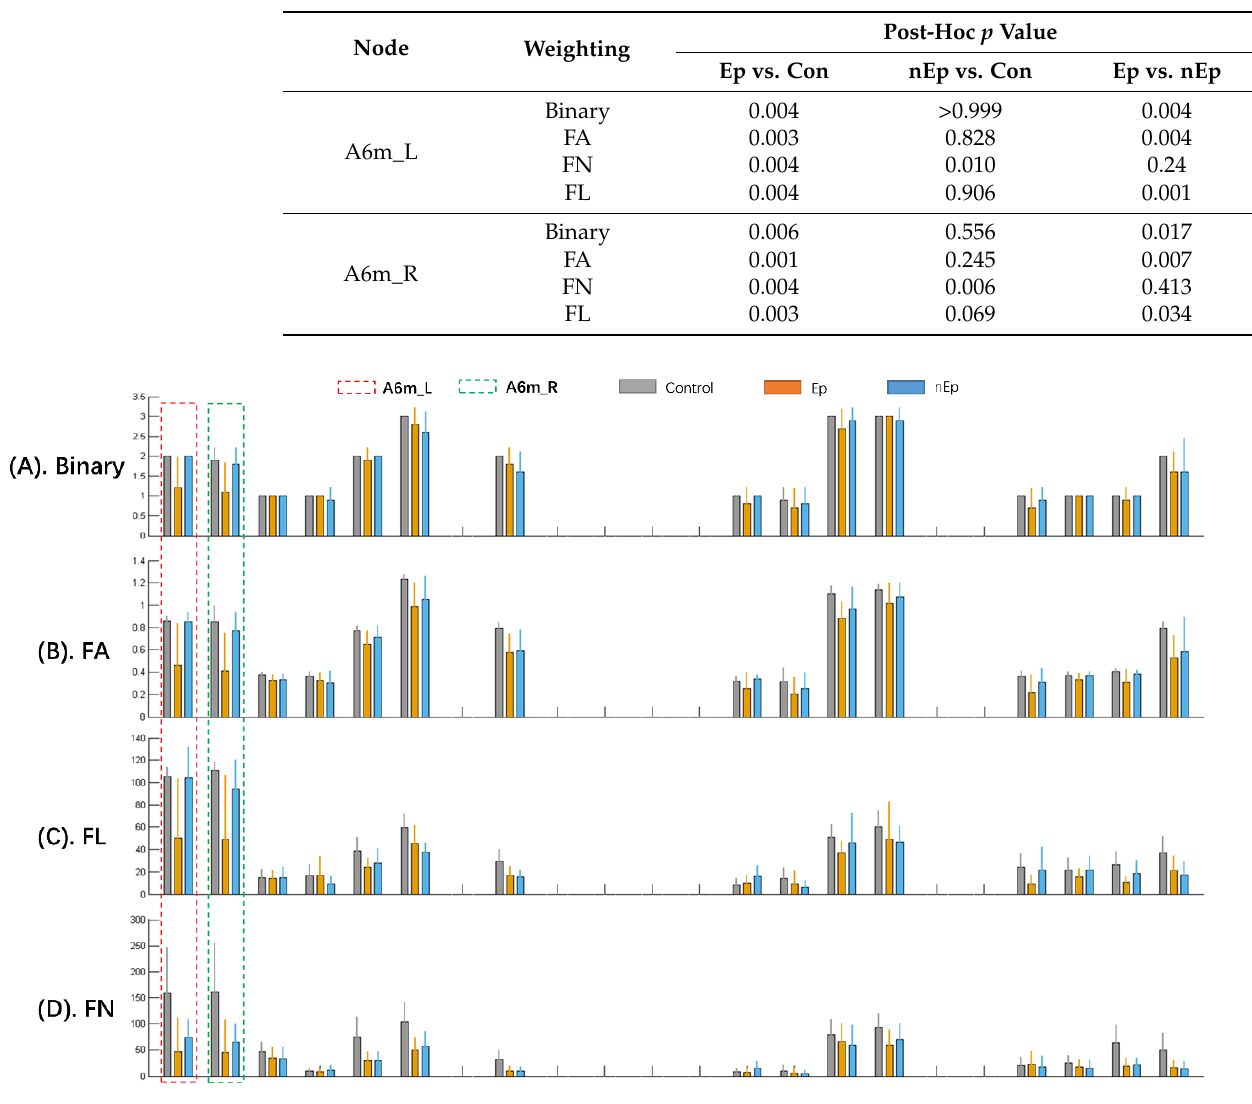
Figure 7. The degree centrality (DC) of the nodes in the motor-sensory network. A6mL and A6mR showed relatively higher DC than the other nodes in both healthy controls and non-ISEs. In addition, the Ep group showed a marked decrease of DC in the A6mL and A6mR. Each three-color bars represents the DC value in one single node. ( A ) Nodal DC values of binary networks. ( B ) Dc values of FA weighted networks. ( C ) DC values of FL weighted networks. ( D ) DC values of FN weighted